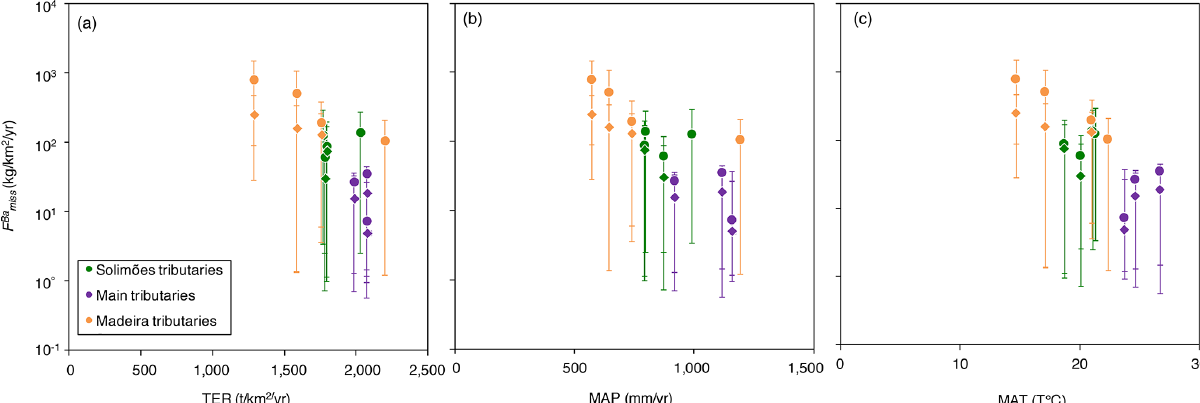
Figure 9. Missing Ba flux ( F Ba ; Eq. 14) vs. (a) terrestrial ecosystem respiration (TER), (b) mean annual precipitation (MAP), and (c) mean miss annual temperature (MAT). Uncertainties have been propagated using Monte Carlo simulation and Gaussian propagation